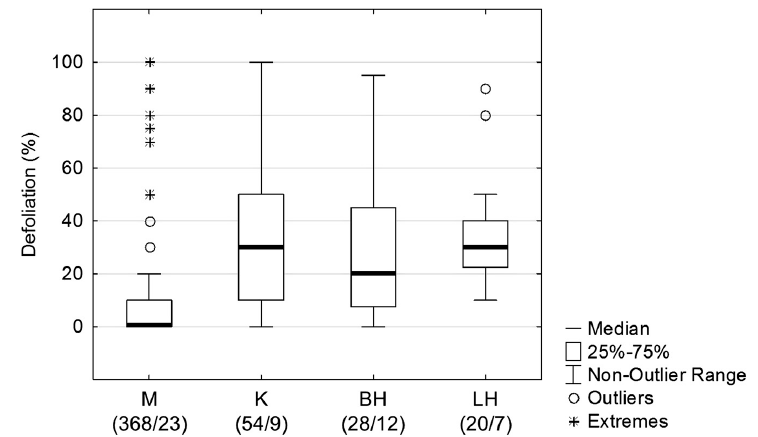
Figure 3. Crown defoliation (in percentages) of ash trees in Slovak arboreta (BH—Borová hora, K—Kysihýbel, LH—Liptovský Hrádok, M—Mly ň any). The number of trees examined/number of taxa is shown in parenthesis under the location name.